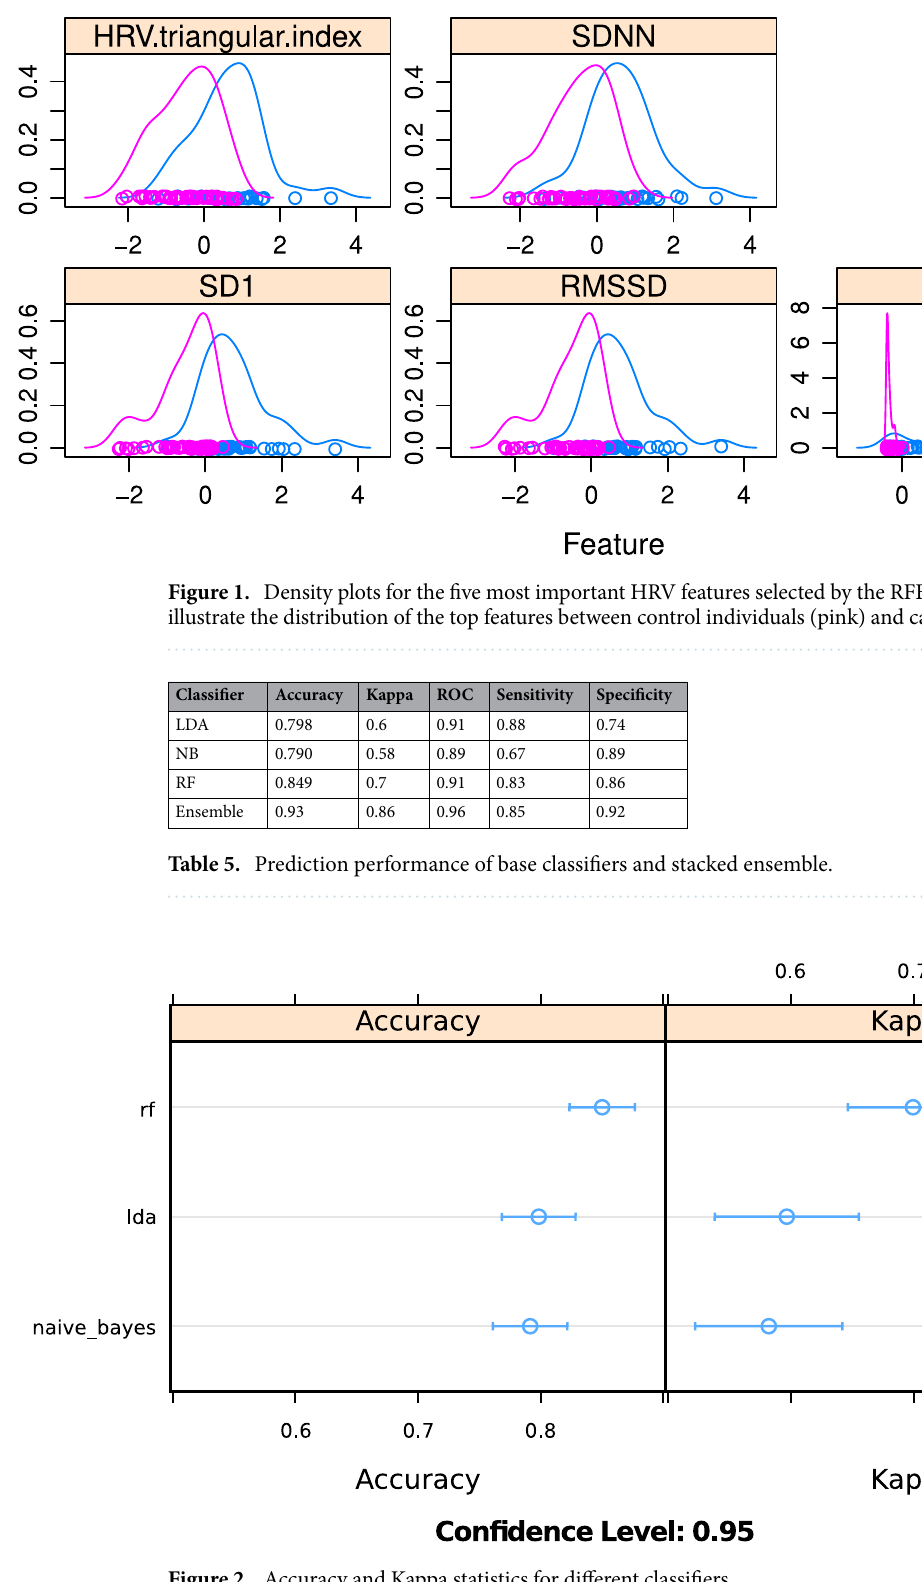
Figure 2. Accuracy and Kappa statistics for different